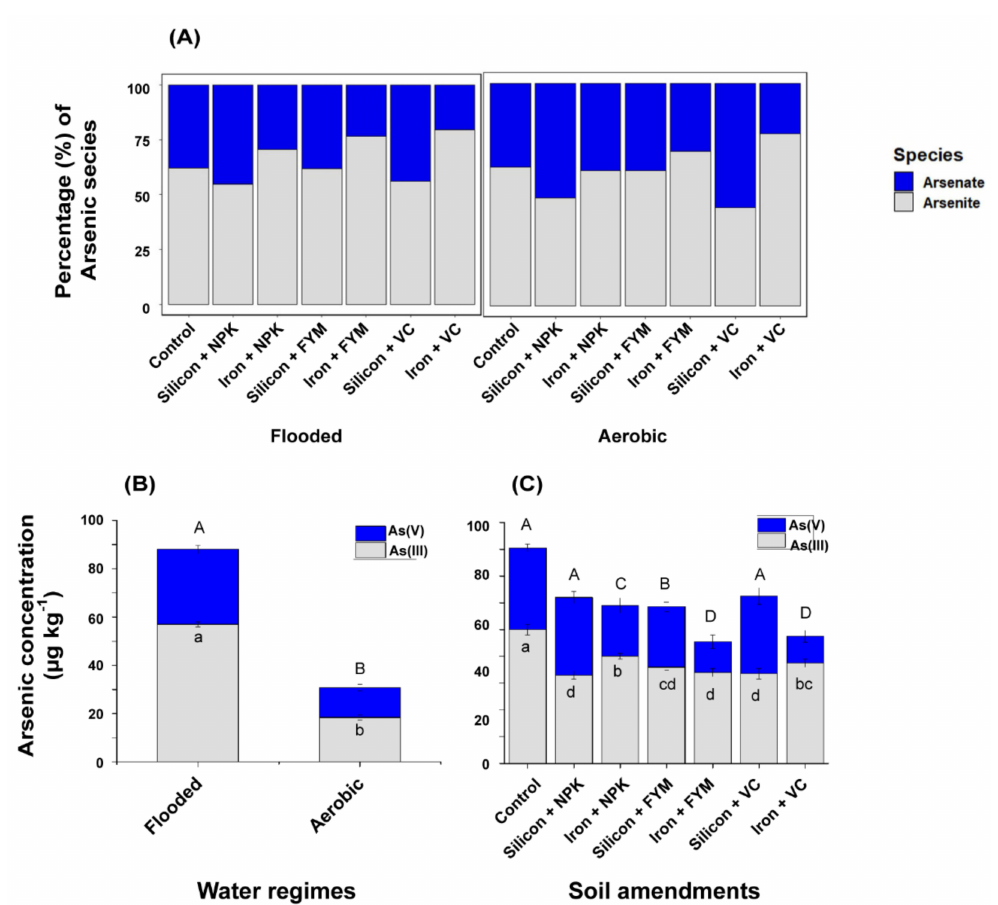
Figure 2. Percentage distribution of inorganic As species in rice grain subject to the effect of soil amendment and water regime ( A ). Arsenite and arsenate concentrations in rice grain in terms of water regime variation ( B ) and soil amendment application ( C ). Error bars represent standard error of means. Different lowercase and uppercase letters indicate significant differences between treatments from Fisher’s LSD test ( p <